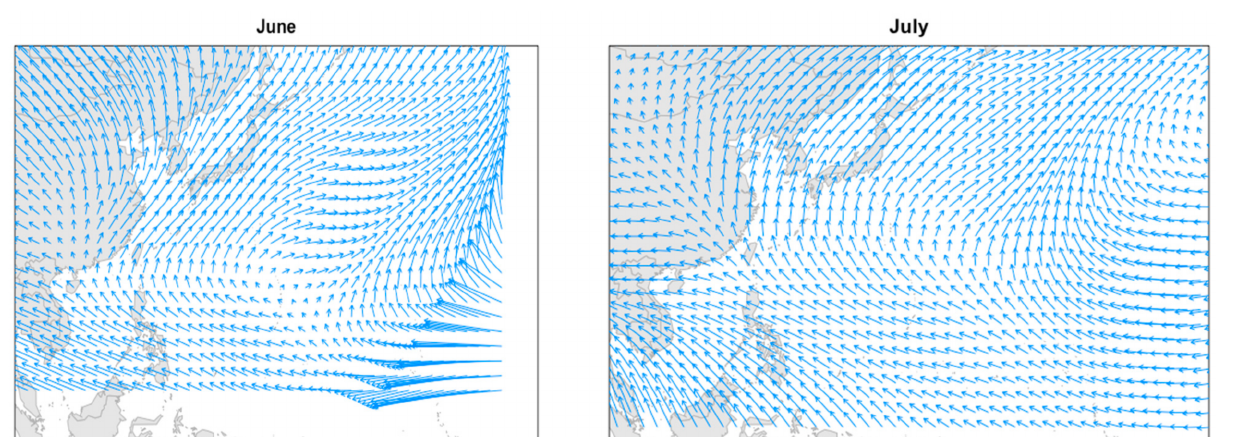
Figure 3. Modeled Distribution of WNP region observed typhoon genesis density in June–September. For each season like July to September, we have fitted the GAM to the observed typhoon tracks. The GAM estimates the typhoon velocities (Figure 4) as a function of each season. In June–July, we can see the westward or northward movement of the fitted typhoon tracks whereas, in the August–September season, it shows a tendency for typhoons to move towards the north, and then recurve towards the